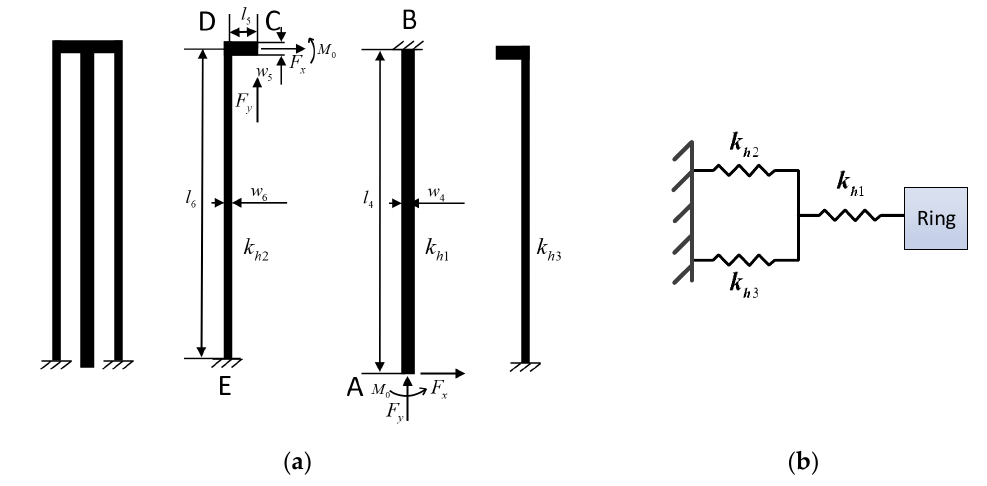
Figure 6. Structure schematic diagram ( a ) and lumped model ( b ) of the hinge beam.